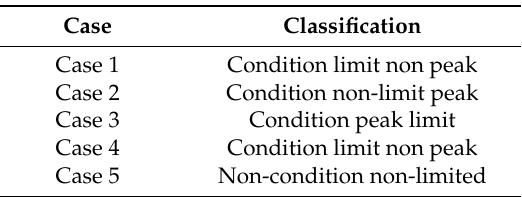
Table 2. Classification results of similar daily [27].